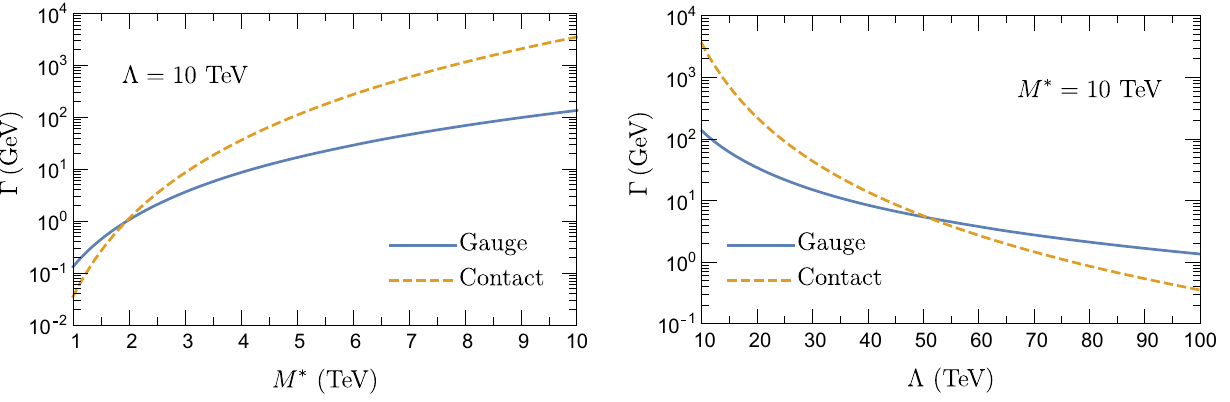
Fig. 2 Gauge- and contact-induced widths, in solid blue and dashed orange, respectively. In the left panel the gauge- and contact-induced widths are shown for masses spanning from 1 to 10 TeV, for a fixed value of (cid:3) = 10 TeV. In the right panel the same widths are shown for